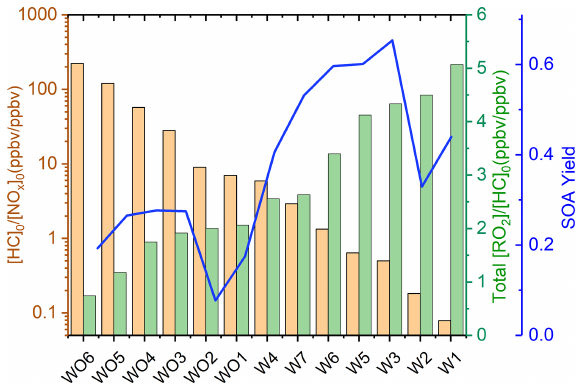
Figure 7. Relationship between total [RO 2 ] / [HC] 0 , [HC] 0 / [NO x ] 0 , and SOA mass